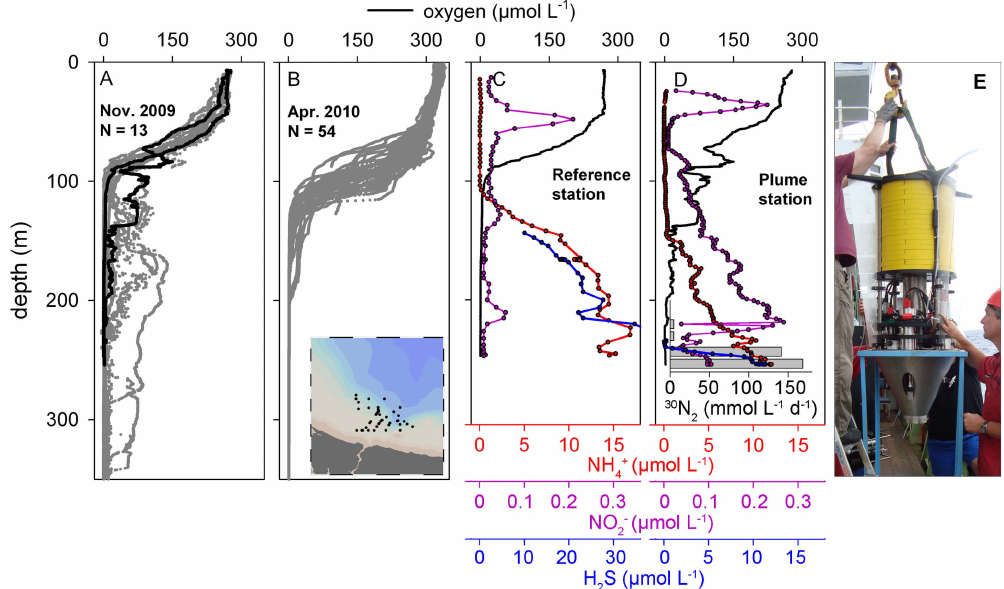
Fig. 23. A and B : Oxygen concentration profiles measured in November 2009 and April 2010 in the Bosporus outlet area (see inset map). The black curves show the examples illustrated in panels ( C ) and ( D ). C and D : Vertical distributions of oxygen, ammonium, nitrite, and sulfide at a reference station and a plume site affected by waters of Mediterranean origin. For the plume station, N 2 production rates at the depth at which sulfide first occurs are provided (gray bars). ( E ) The free-falling pump CTD just before deployment. The sensors for temperature, salinity, and oxygen, and the inlet of the pump, protrude out of the downward-facing cone. The yellow-painted syntactic foam provides buoyancy to the upper part of the pump CTD. In free-falling mode the pump CTD descends slowly along a wire that runs through the center of the